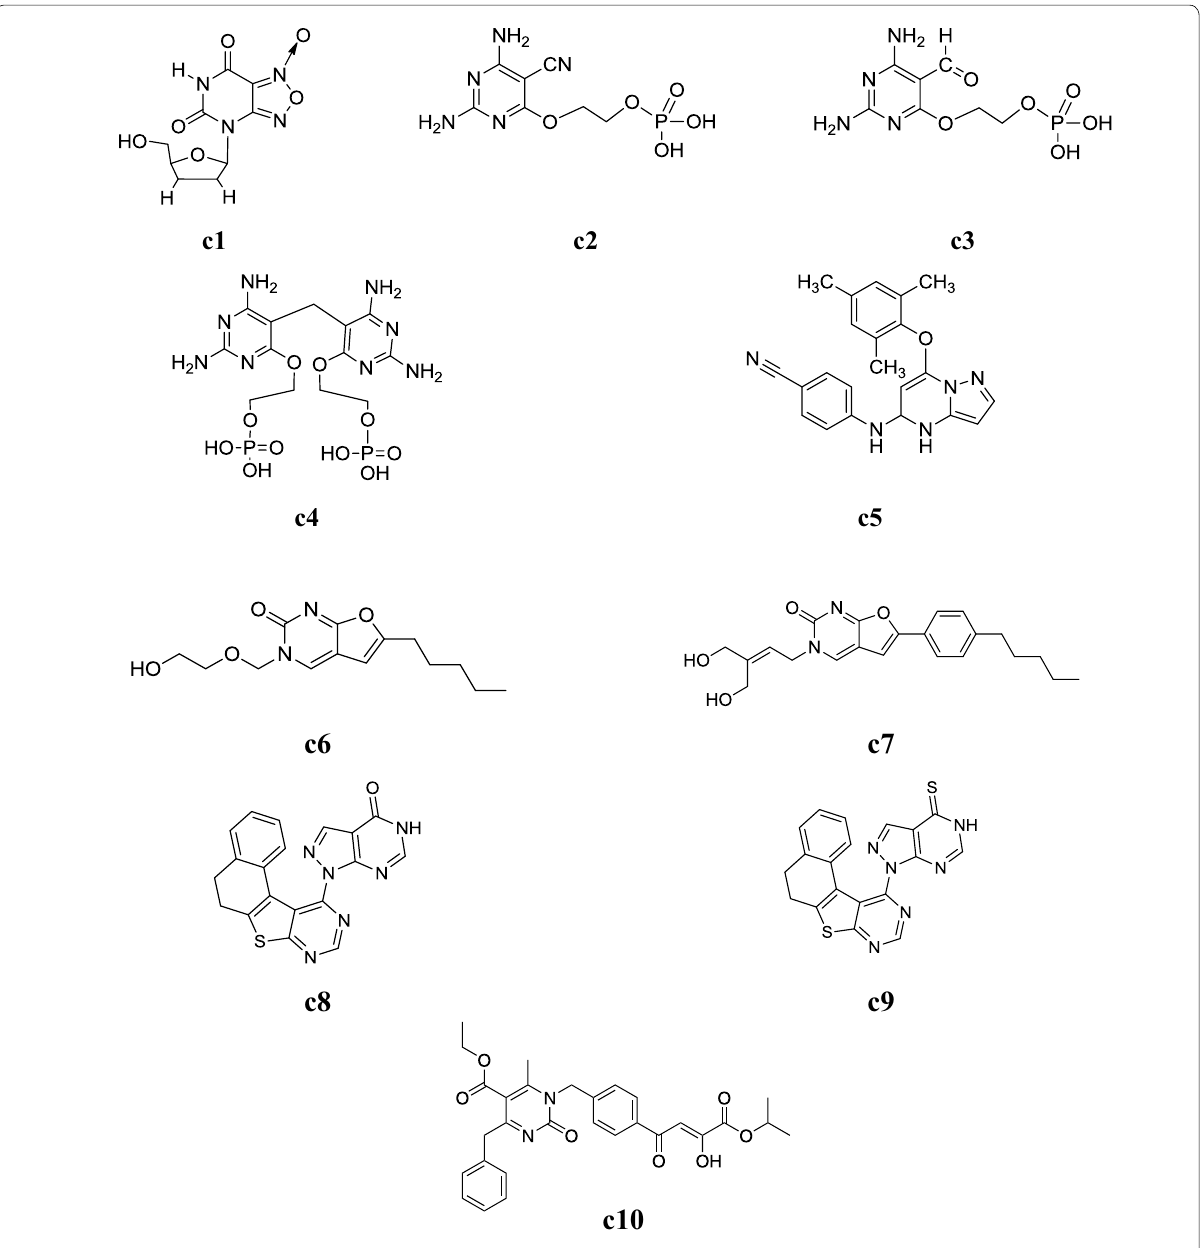
Fig. 8 Chemical structures of the most active antiviral pyrimidine derivatives ( c1 – c10